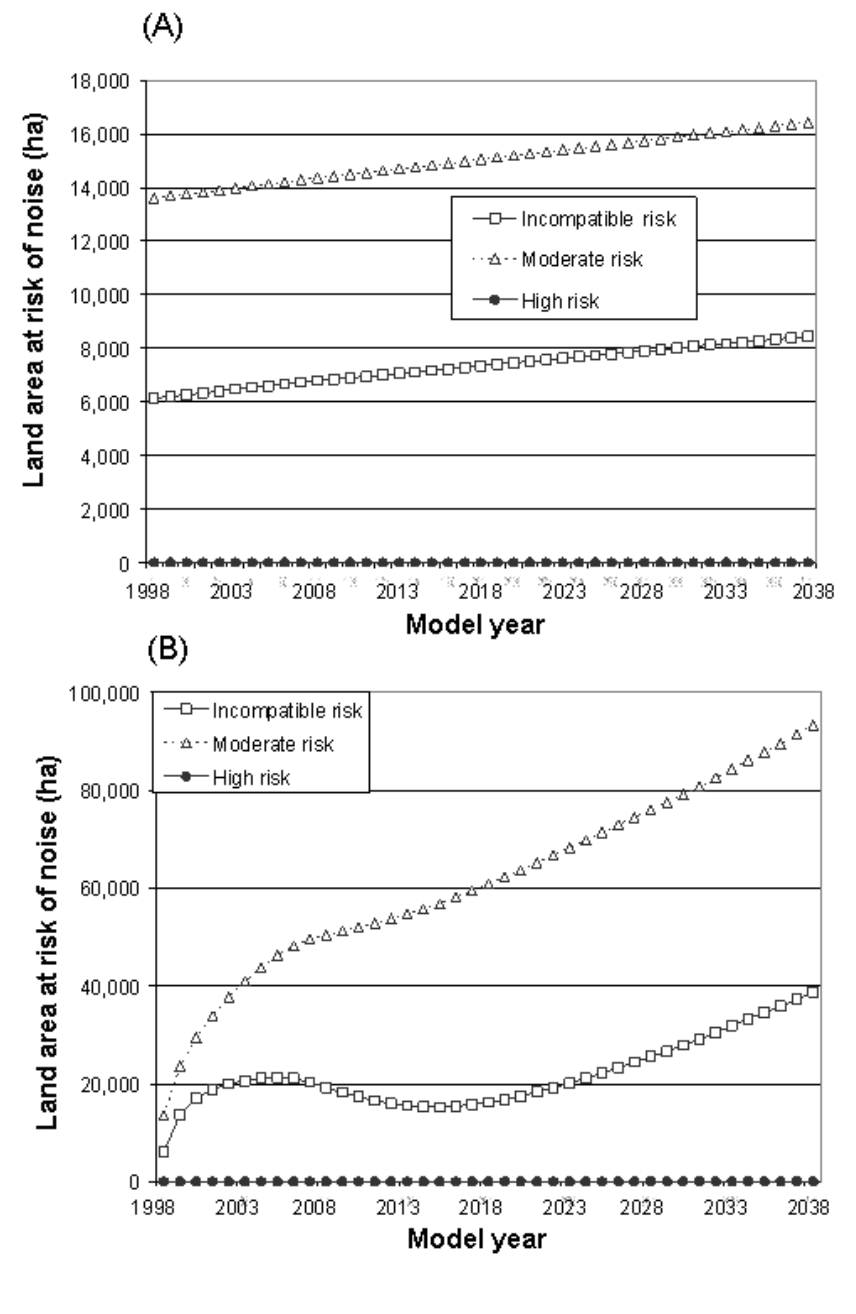
Fig. 6. Projected changes in land area at moderate or high risk of noise complaints and with incompatible land uses for the projected noise risk for the (A) business as usual scenario and (B) high urban growth scenario over the 40-yr projection